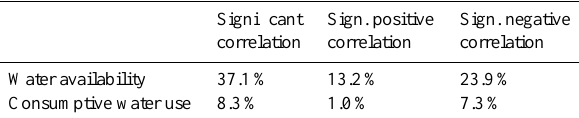
Table 2. Percentage of the global land area for which (a) water re- sources availability and (b) consumptive water use show a signifi- cant (positive/negative) correlation with ENSO-driven climate vari- ability (as assessed with the JMA SST anomaly index).